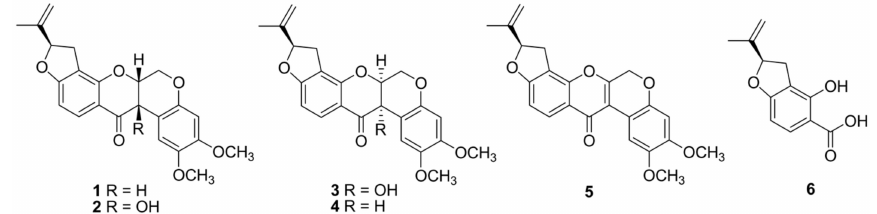
Figure 3. Structures of newly thermolysis products 2 – 6 of